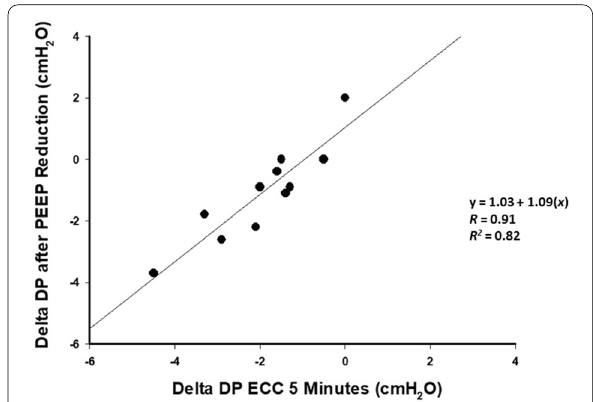
Fig. 2 Change in driving pressure produced by ECC vs. change in driving pressure produced by PEEP reduction. N 11. Relationship = between variations in driving pressure obtained after 5 min of ECC (5 min ECC driving pressure—baseline driving pressure) and variations in driving pressure obtained after PEEP reduction (PEEP reduction driving pressure—baseline driving pressure). A strong 0.82, P < 0.001) was observed between these correlation ( R 2 = variables. ECC external chest-wall compression, DP driving pressure